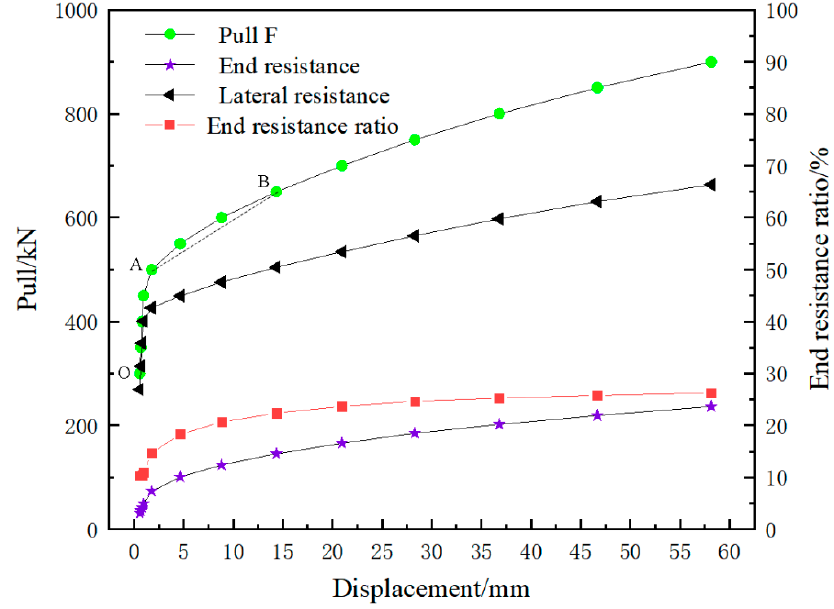
Figure 6. Relation curve of tension, side resistance, end resistance, and displacement.